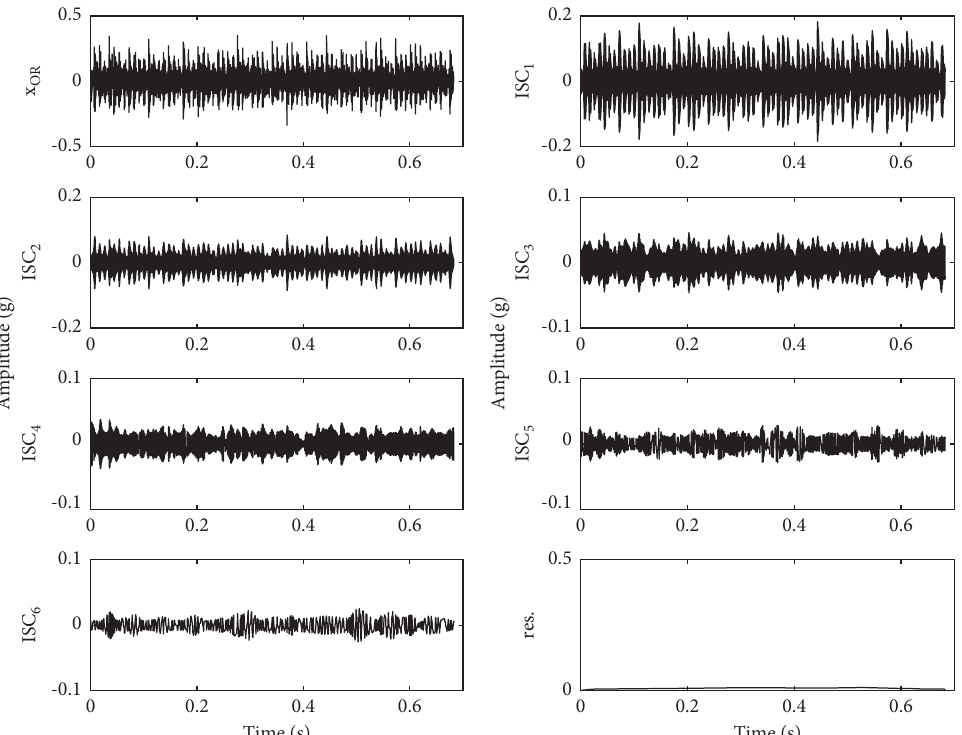
Figure 11: LCD decomposition results of x-channel under outer race fault condition.